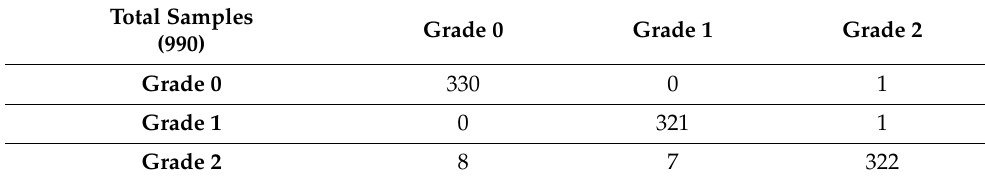
Table 8. Testing confusion matrix of ADAM empowered with AlexNet (augmented test data).